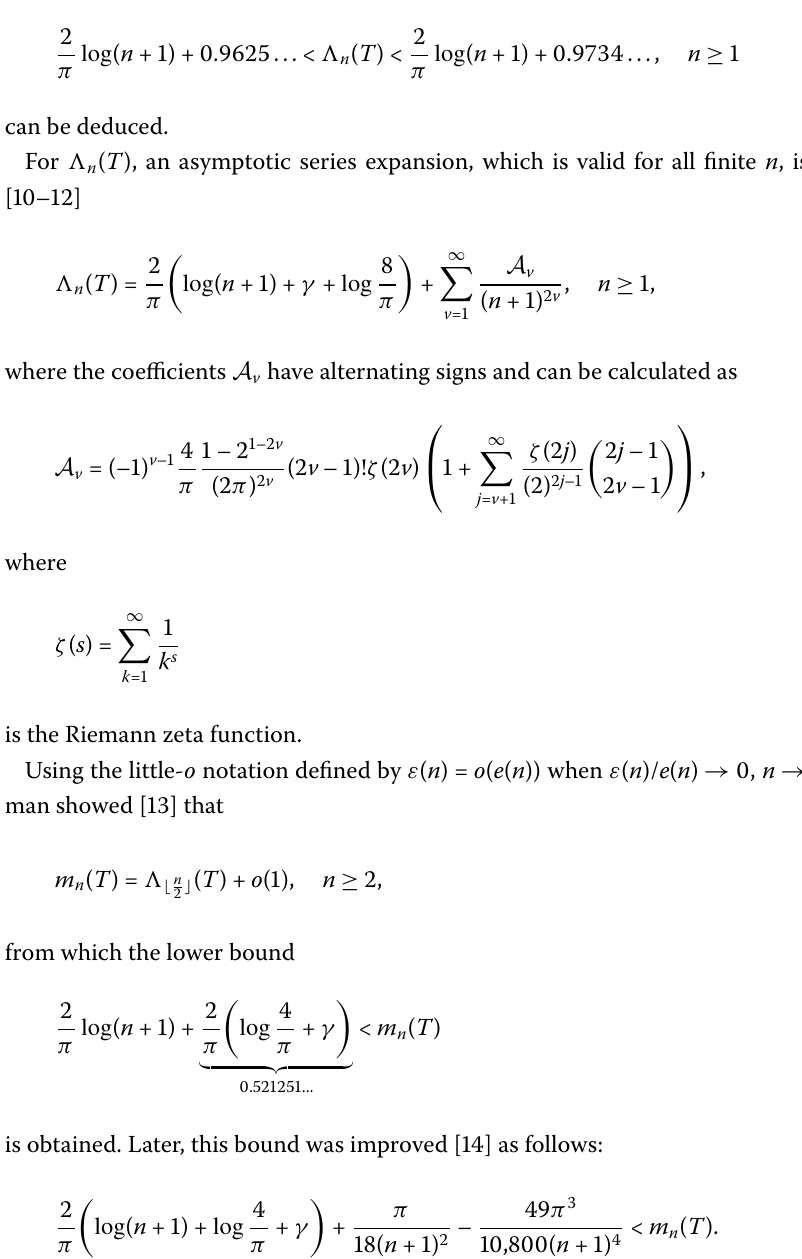
from which the upper and lower